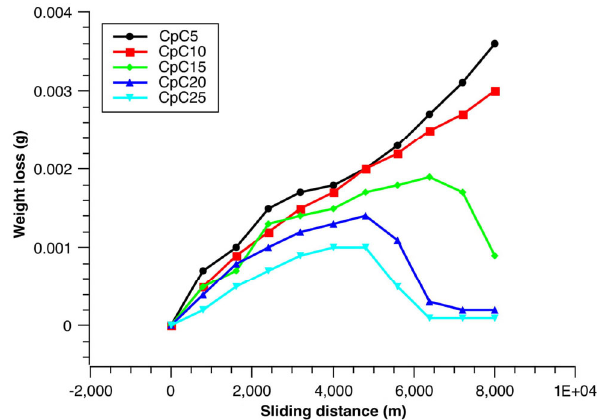
Fig. 6 Weight loss of samples at 20 N load.